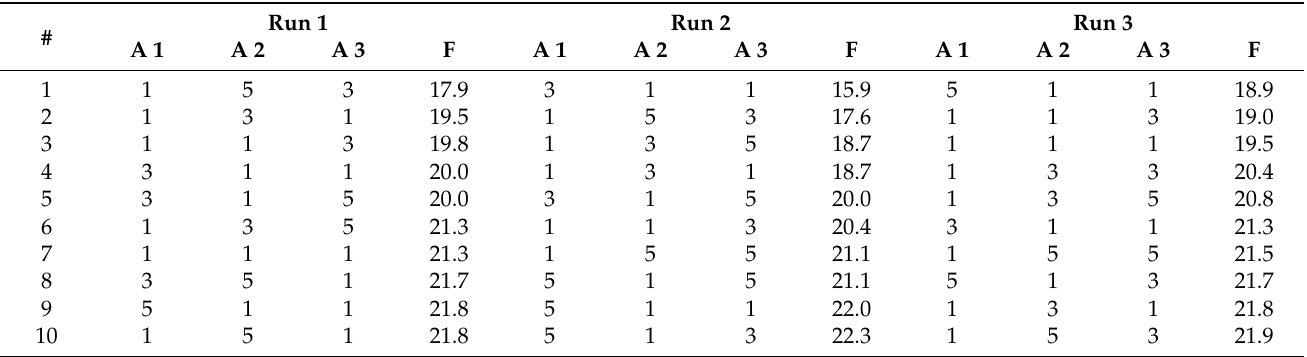
Table 6. Best ten combinations of the three repetitions; the search strategies are coded as follows: